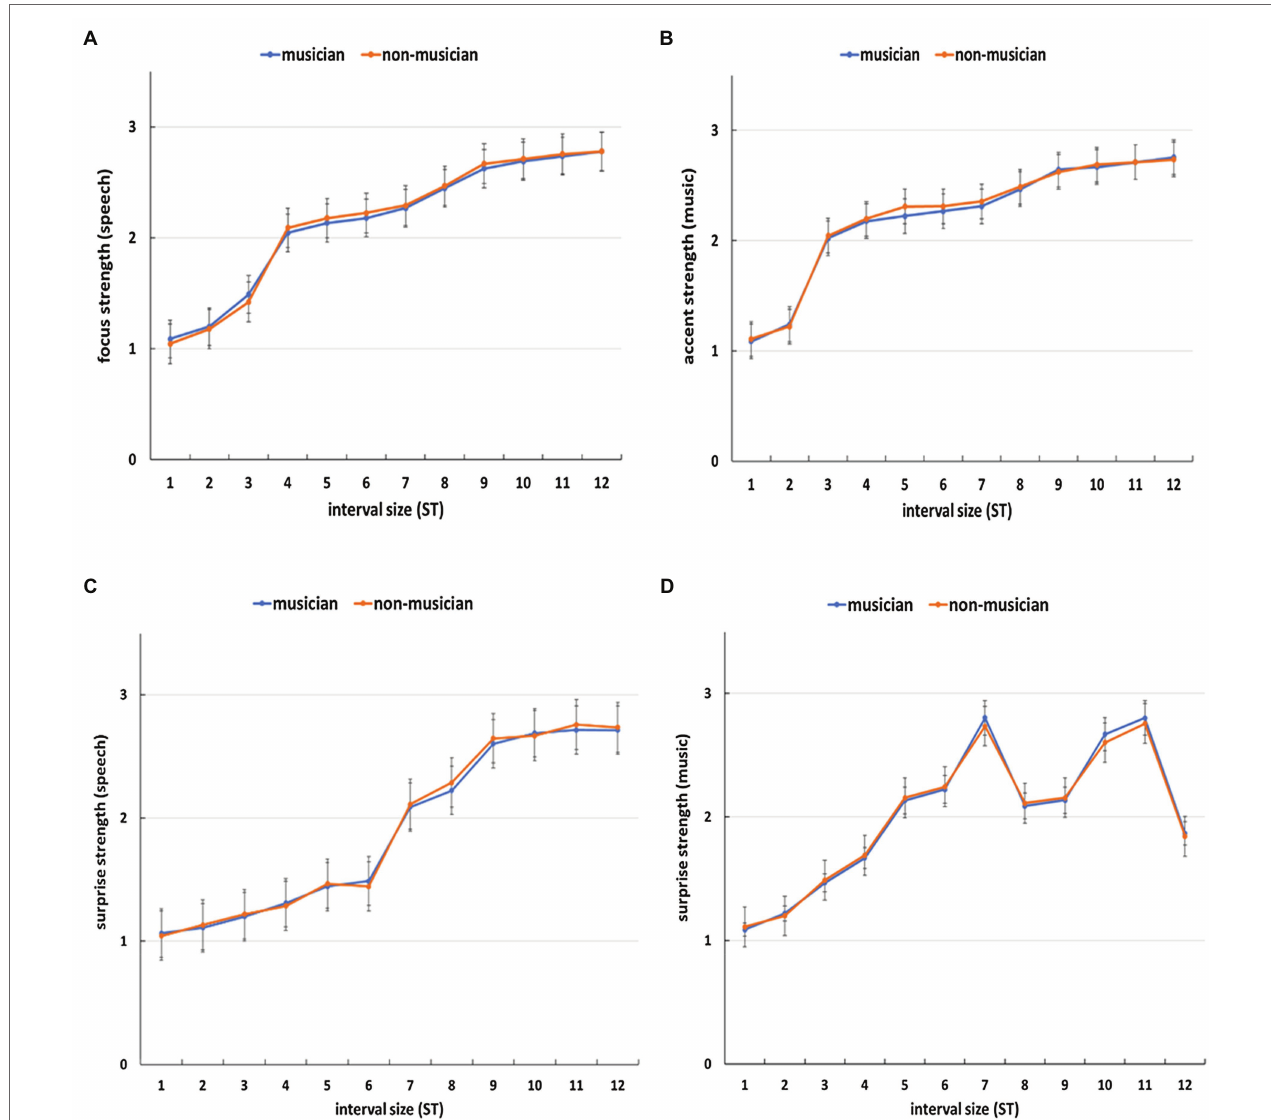
FIGURE 6 | The average ratings of focus/accent strength [ (A) for speech and (B) for music] and surprise strength [ (C) for speech and (D) for music] for each interval size (ST = semitone). Error bars represent standard error of the